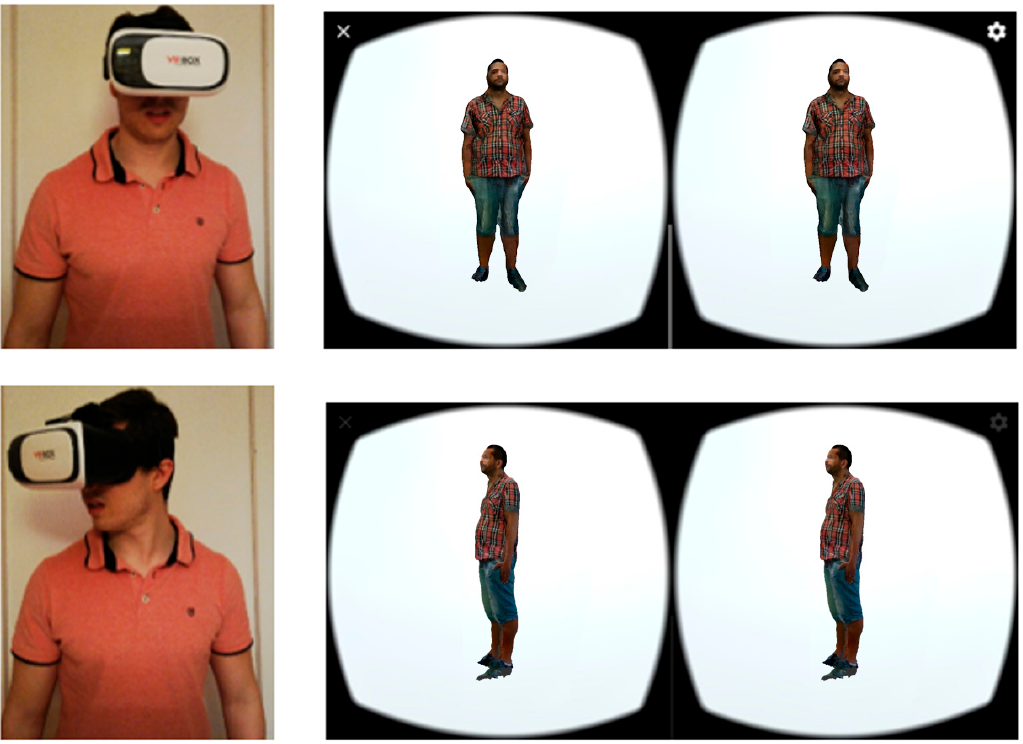
Figure 6. Transmission of motion to the 3D model (left) head positions (right) stereo images